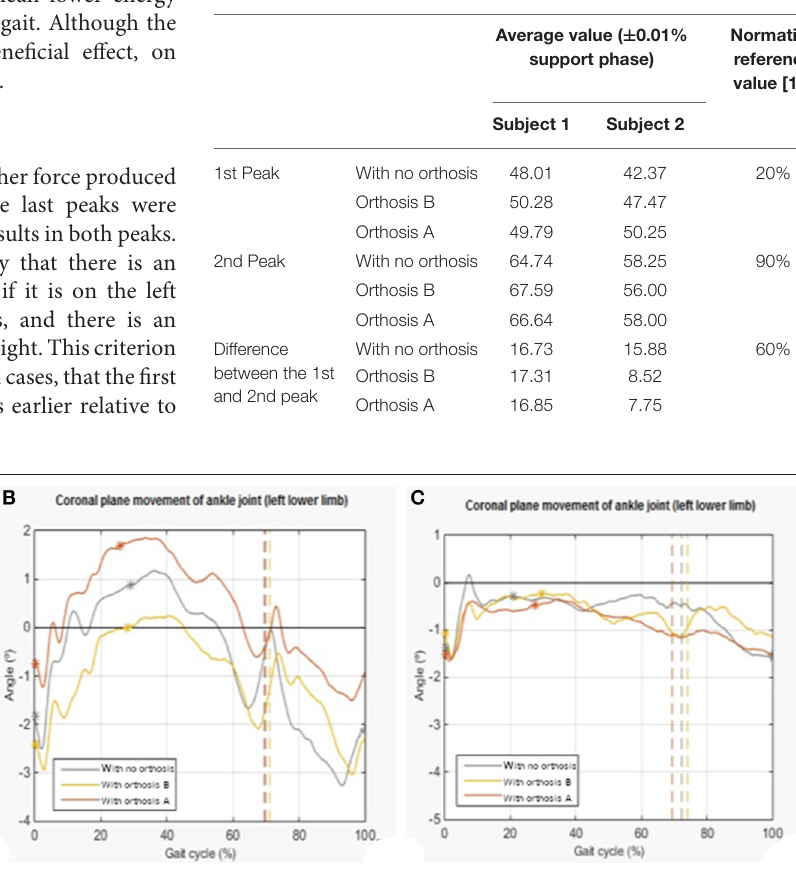
Frontiers in Digital Health |